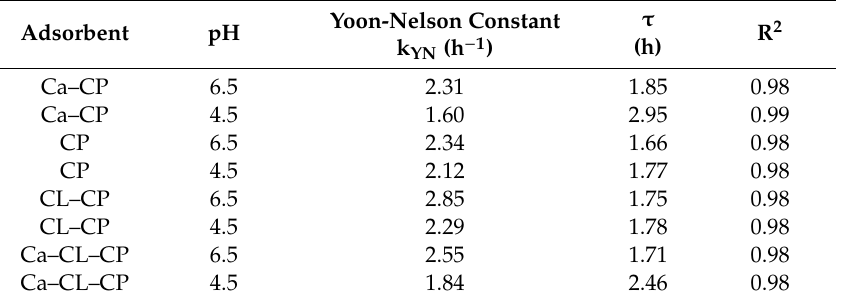
Table 3. Yoon–Nelson model constants for di ff erent adsorbents at 25 ◦ C and variable pH.